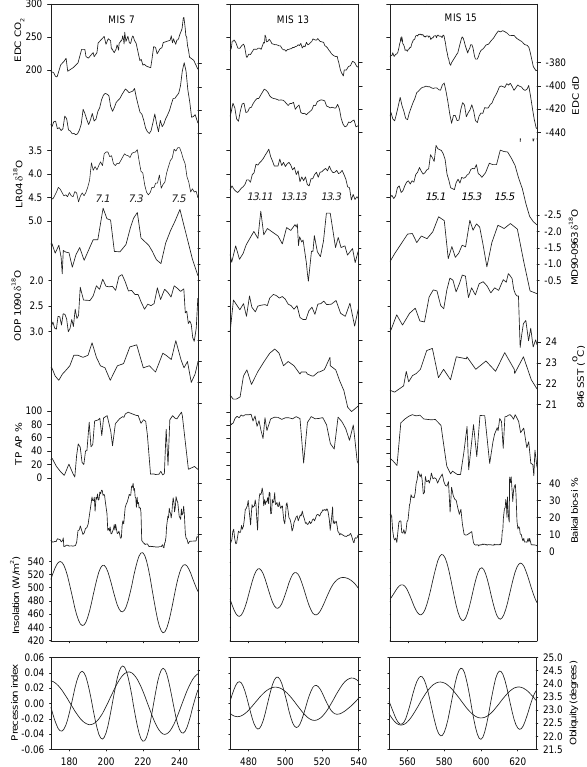
Fig. 7. Interglacial stages 7, 13 and 15 showing multiple interglacial peaks in selected records. Sub-stages are given in